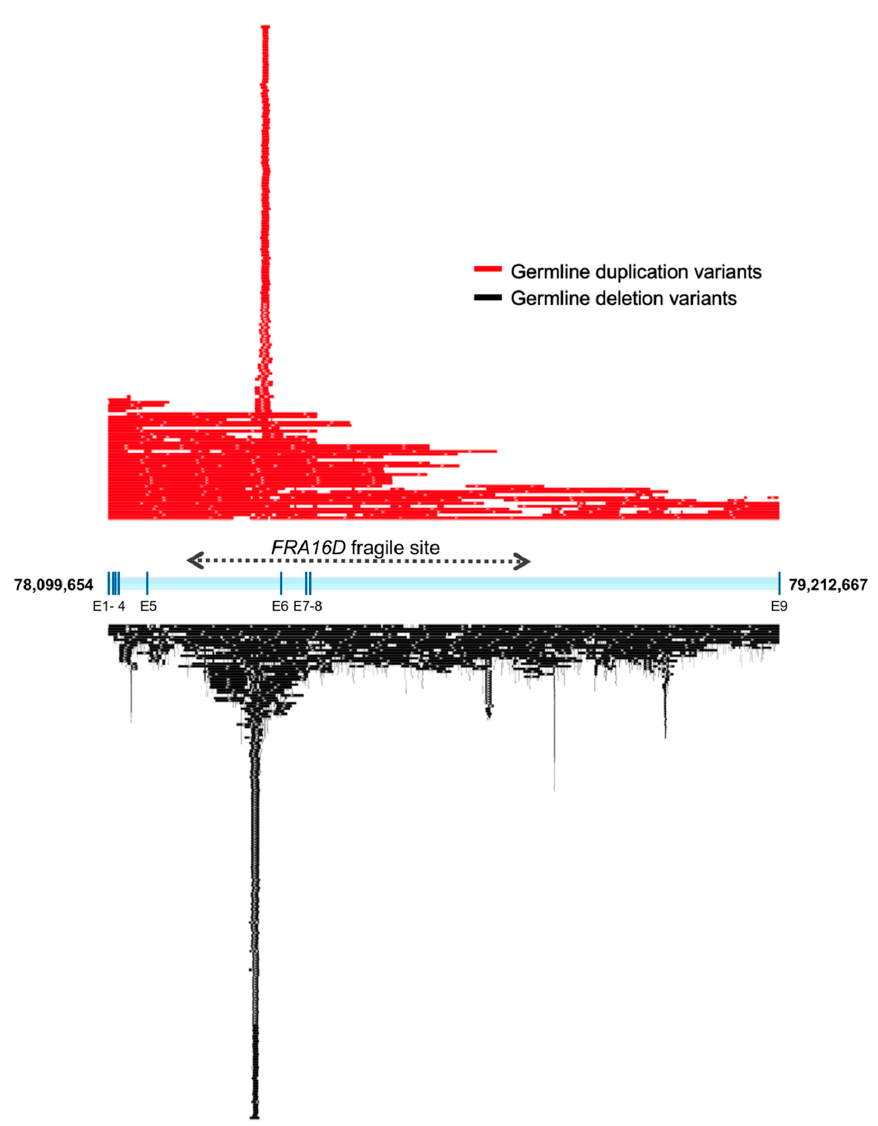
Figure 9. WWOX is a hotspot for germline CNV polymorphisms in healthy humans. Mapping of non-redundant WWOX intragenic germline duplications (red) and deletions (black) variants in normal human population. Larger CNVs spanning beyond WWOX with one of the breakpoints within the gene are also shown. As can be observed there is a significant accumulation of germline CNVs clustering in a specific hotspot within intron 5. This hotspot overlaps the 5 ′ prime edge of the core of FRA16D (dotted line).